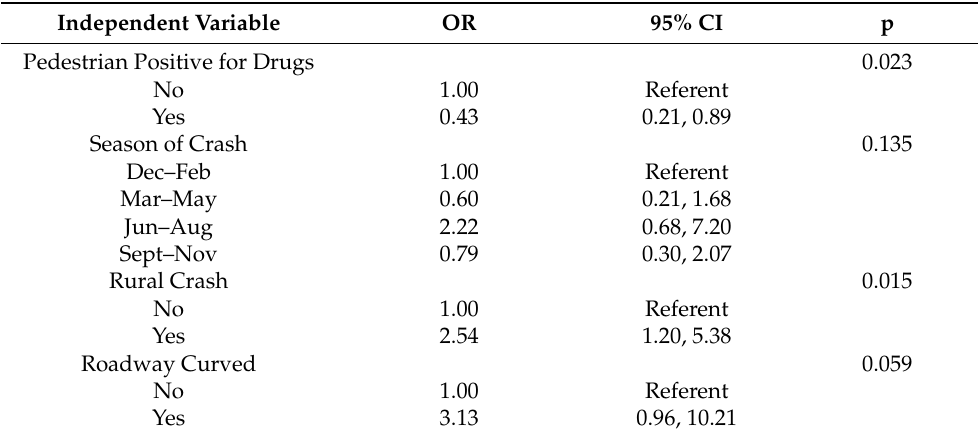
Table 3. Factors that predict male vs. female fatal, pedestrian, motor vehicle crashes in West Virginia, 2009–2019 a.